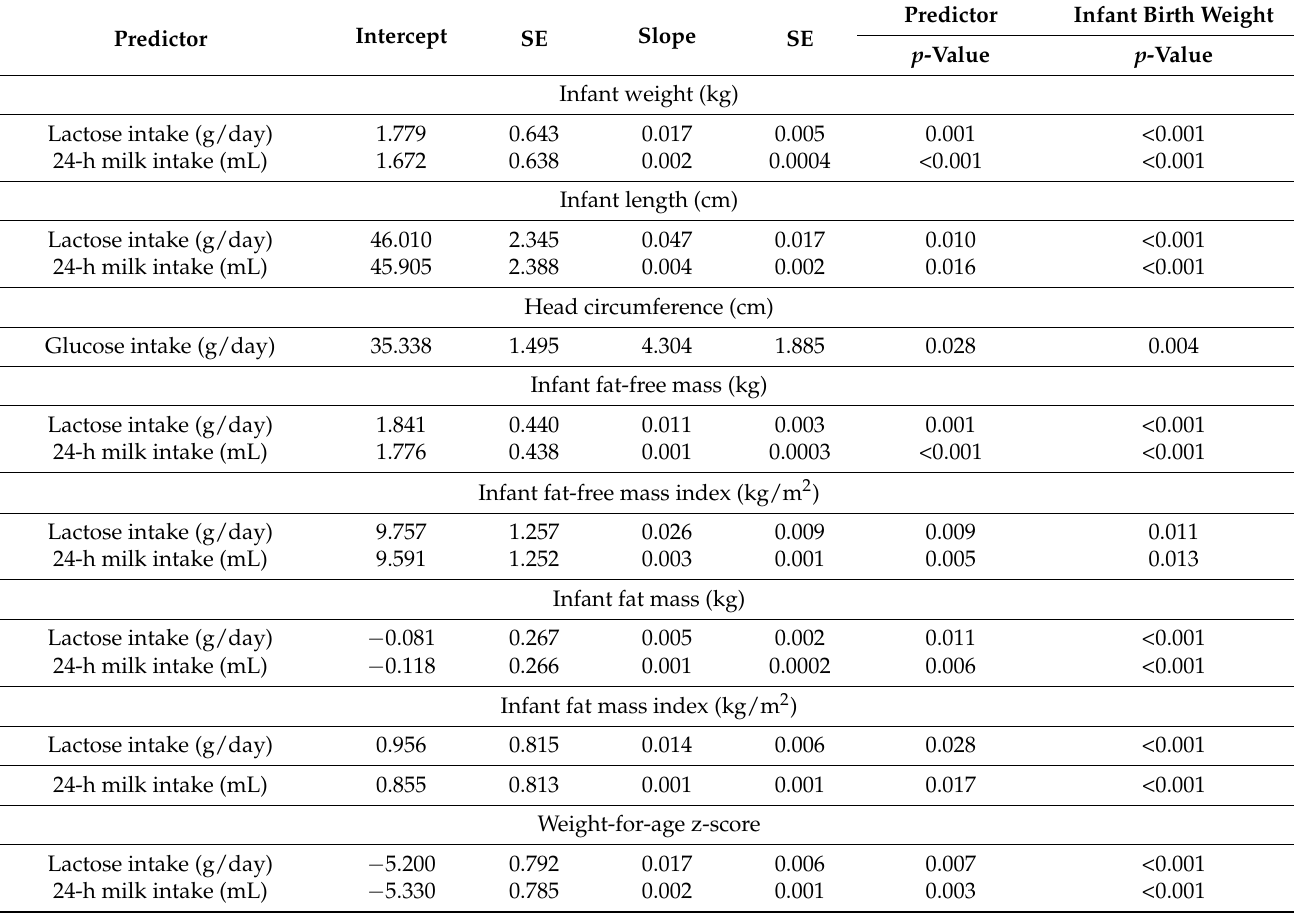
Table 3. Associations between infant body composition and 24-h milk and lactose intakes at 3 months postpartum. Predictor